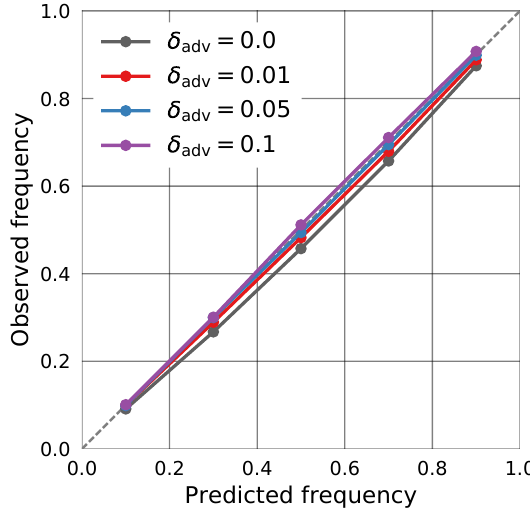
Figure 8. Calibration of the QRNN prediction intervals on the val- idation set used during training. The curves display the results for no adversarial training ( δ adv = 0) and adversarial training with per- turbation factor δ adv = 0 . 01 , 0 . 05 , 0 .